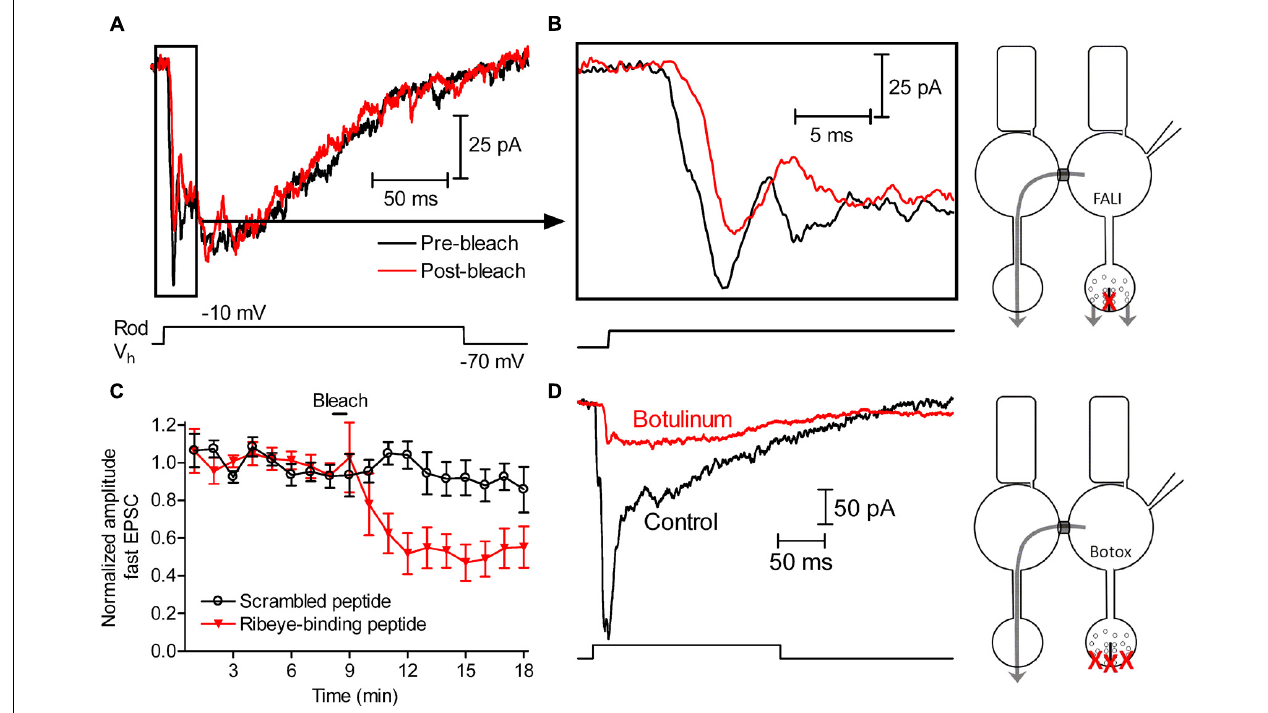
FIGURE 1 | Slow release at rod synapse is largely independent of ribbon function. (A) EPSCs recorded from a horizontal cell voltage-clamped at − 60 mV and evoked by 200-ms steps ( − 70 to − 10 mV) applied to a rod before (black) and after (red) damaging ribbons.We show the third response obtained after fluorophore-assisted laser inactivation (FALI) with a fluorescein-conjugated Ribeye-binding peptide (80 μ M). After FALI, ribbon release from the patched rod should be inhibited, but non-ribbon release from the patched rod and all of the release from neighboring rods depolarized through gap junctions should remain the same (as shown in the scheme). (B) To better illustrate the decrease in the initial fast component of release